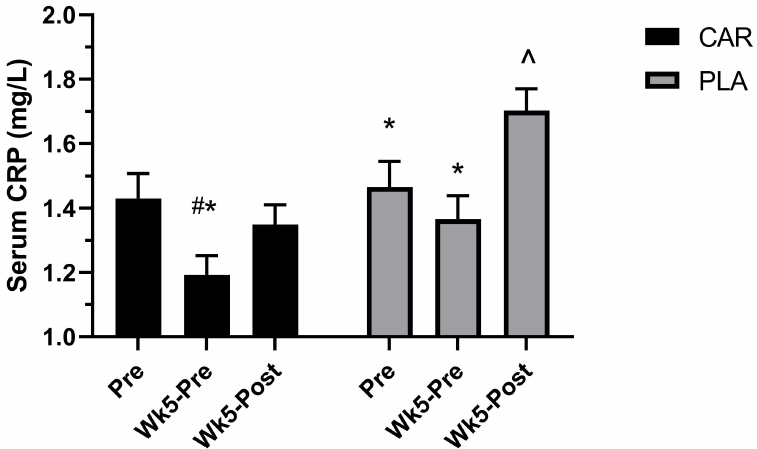
Figure 8. Serum C-reactive protein (CRP). Mean values and error bars for the standard error of the mean of serum C-reactive protein (CRP) levels are shown. # indicates a significant difference from Pre ( p < 0.001). * indicates a significant difference from Wk5-Post ( p < 0.005). ˆ indicates a significant difference between groups ( p < 0.001). The groups are carnitine (CAR) and placebo (PLA)